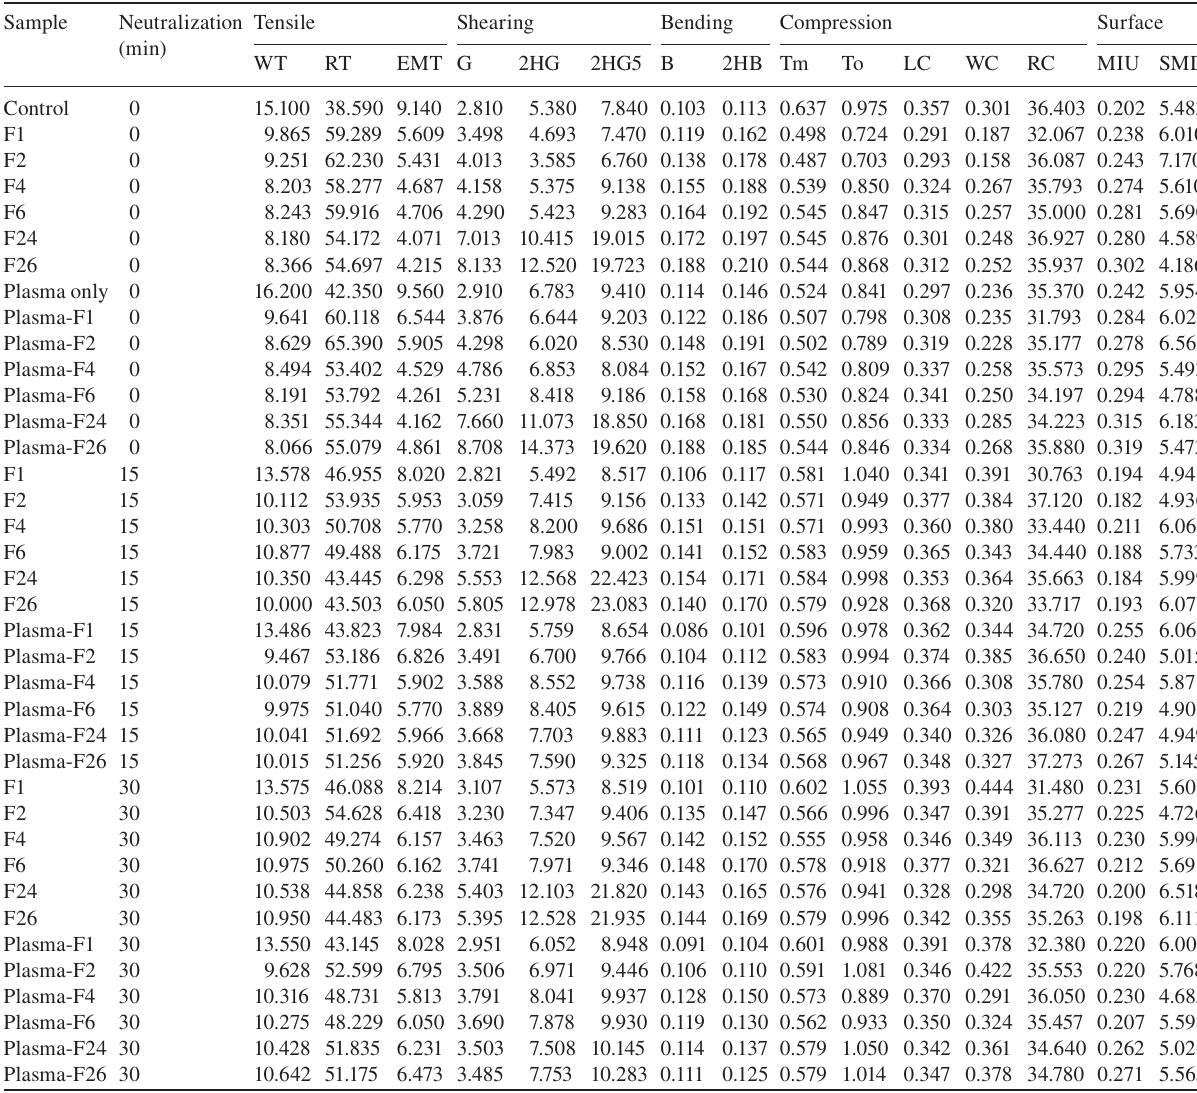
Table 2 Different properties of the treated fabric as measured by the KES-F